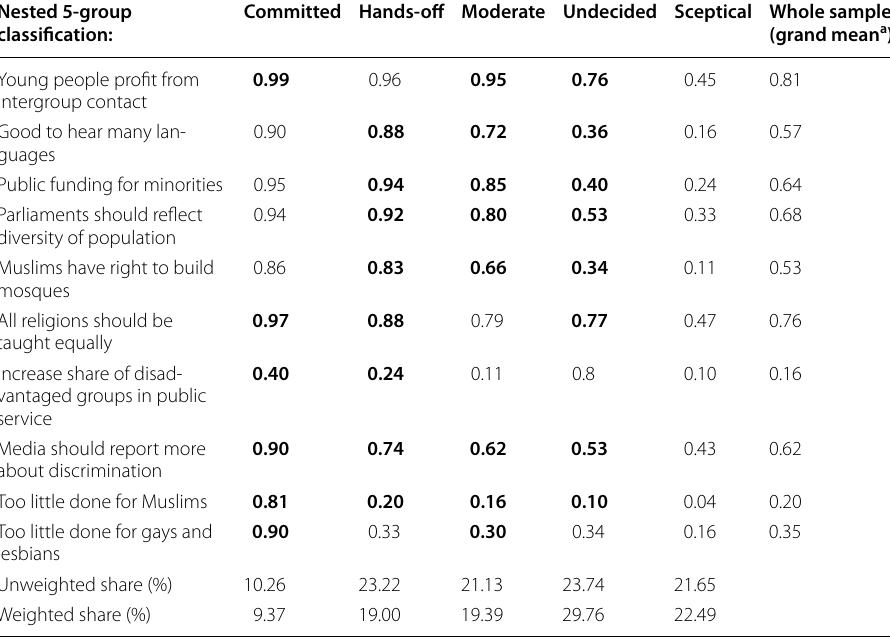
Table 1 Configurations of attitudes towards various aspects of diversity in urban Germany Nested 5‑group